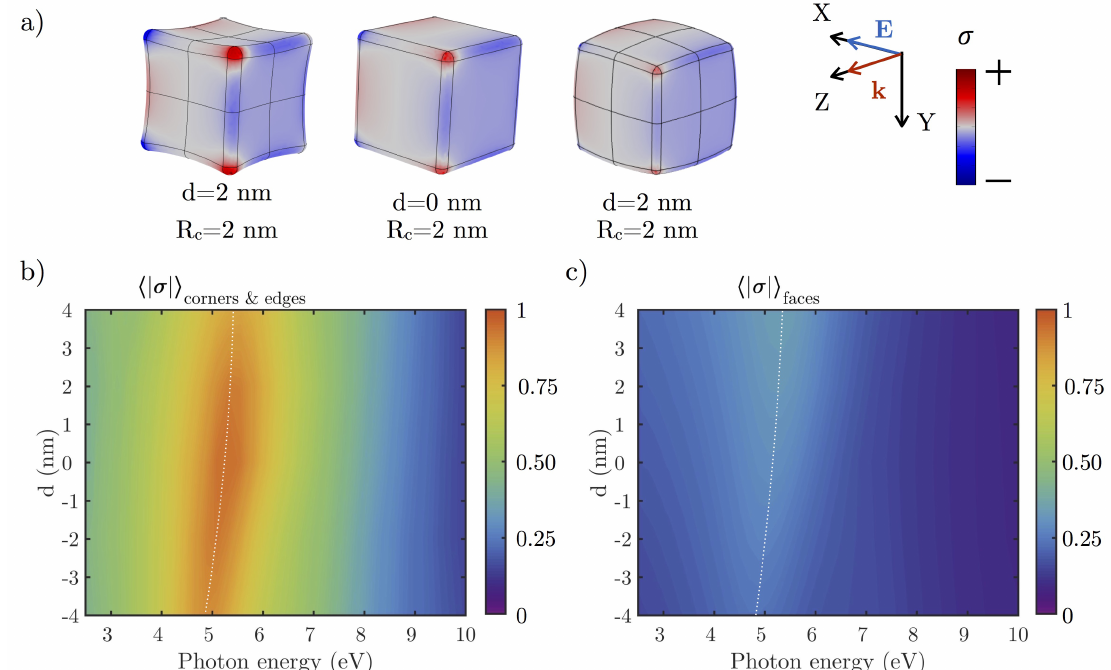
Figure 8. ( a ) surface charge distribution ( σ ) over concave and convex Rh NCs with L = 30 nm and R c = 2 nm when illuminated at resonance. The red/blue regions represent positive/negative charge densities. Normalized values of σ averaged over ( b ) the edges and corners; and ( c ) over their deformed faces of the